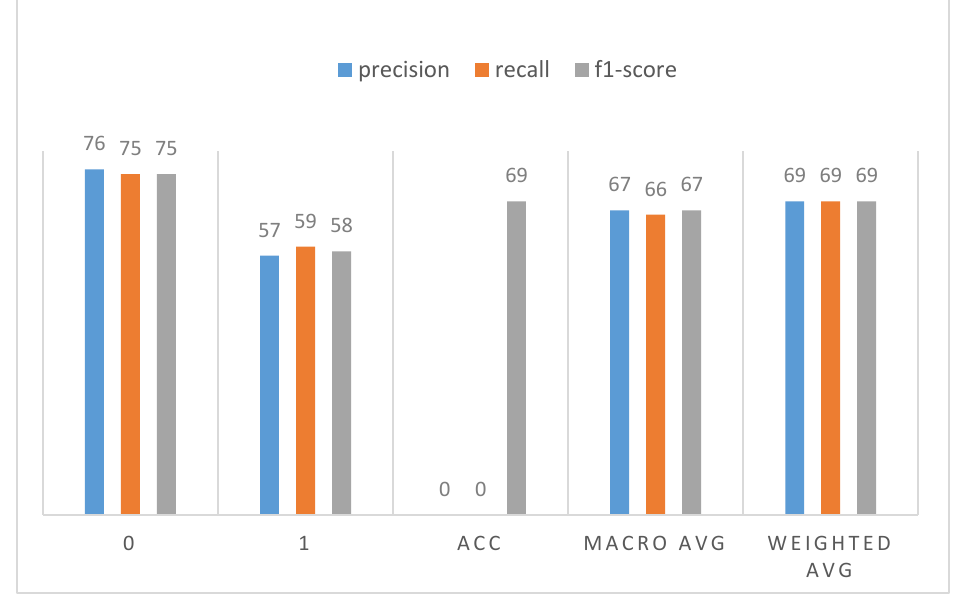
Figure 16. Summary of results for a testing dataset equal to 70% and training dataset of 30%. The results presented in Figure 16 are not significantly different from the graph presented in Figure 15. Changing the size of the training (30%) and testing (70%) dataset did not affect the values of the individual parameters to a large extent.